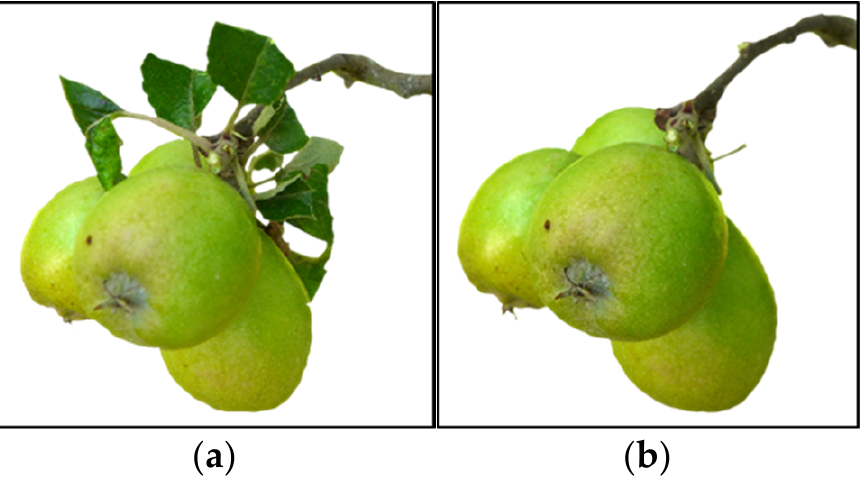
Figure 1. Source-sink modification by cluster leaf removal at fruit set: ( a ) 50% cluster leaves removed, and ( b ) 100% cluster leaves removed (photos: ca. 2 months after treatment).